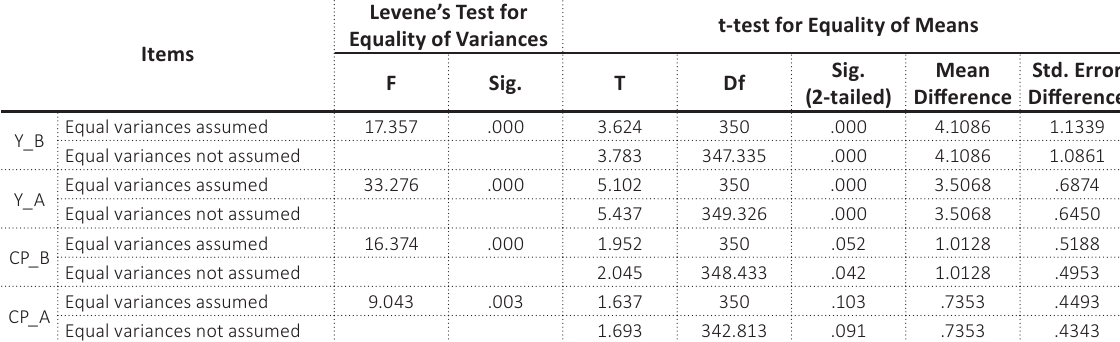
Table 3. Independent sample